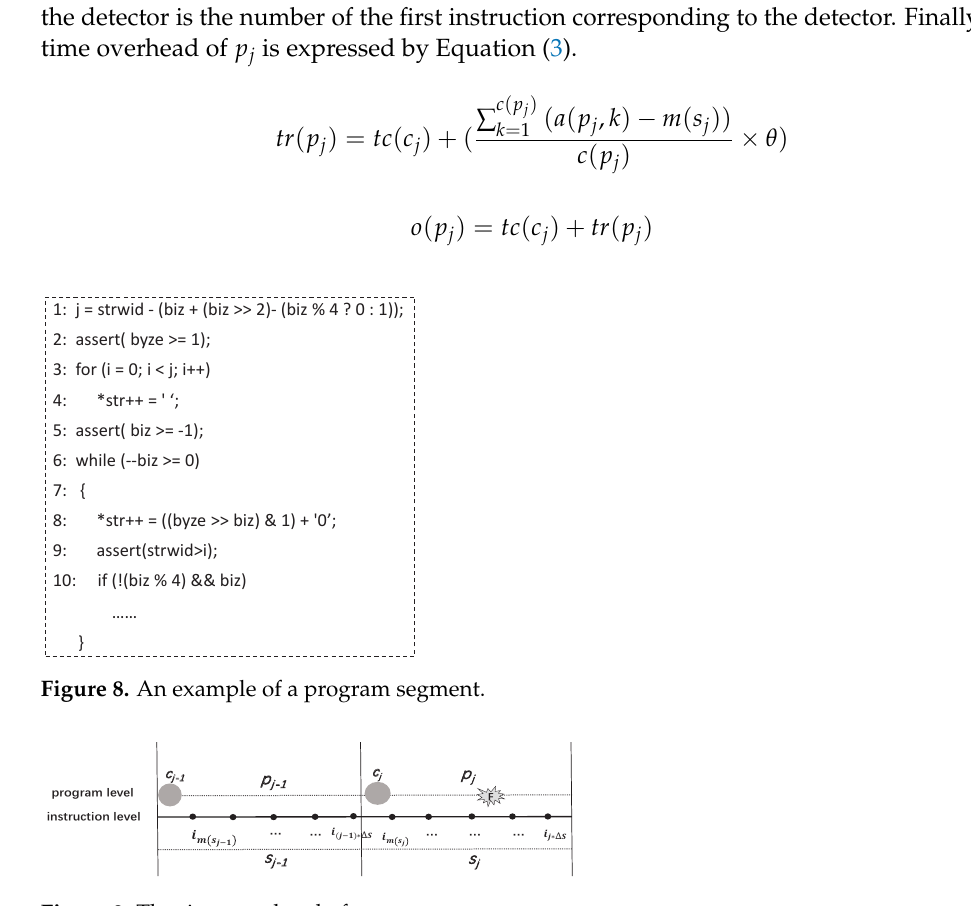
Figure 9. The time overhead of a program segment.